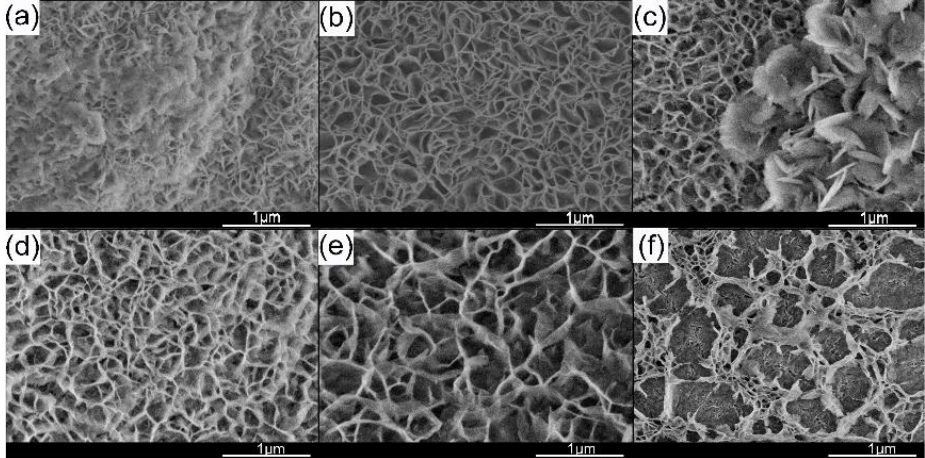
Figure 6. SEM images of as-prepared Mg(OH) 2 on electrode surface. ( a ) Additive free; ( b ) 0.2 g/L; ( c ) 0.4 g/L; ( d ) 0.6 g/L; ( e ) 0.8 g/L; ( f ) 1.0 g/L.